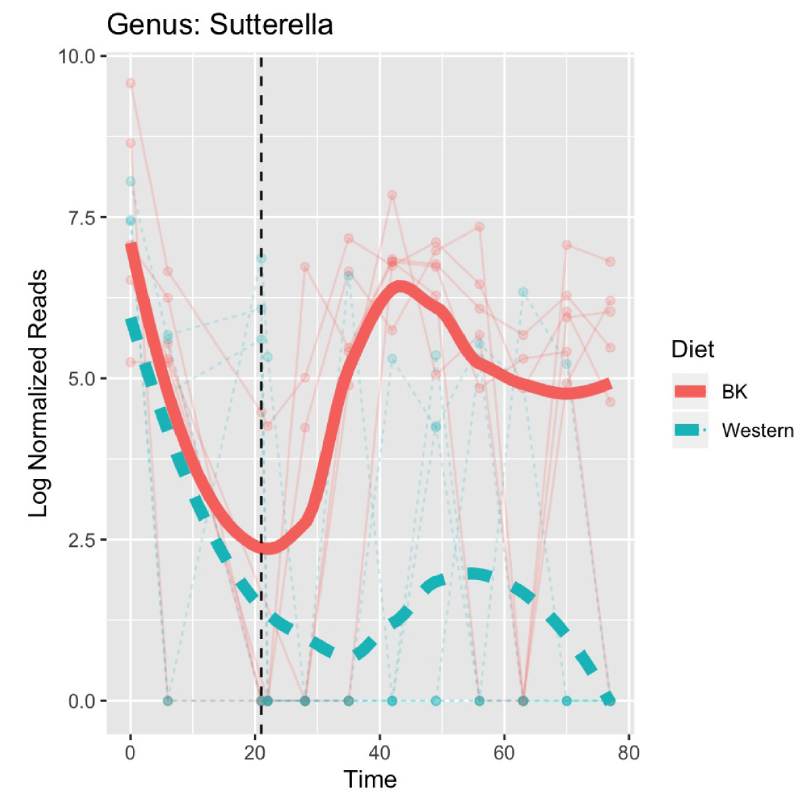
Figure 3. Observed longitudinal trends for the two diet groups in Turnbaugh et al. 10 study for the Genus Sutterella with estimated LOESS curves for each group. Note that both groups had equivalent diets over the first 21 days with half of the mice switching to the Western diet at this point marked with the vertical dotted